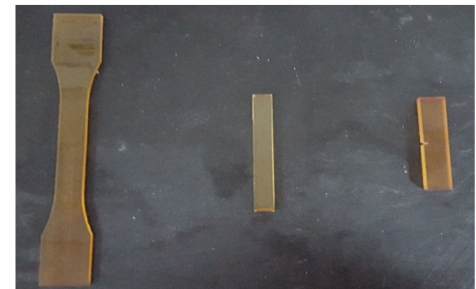
Figure 1. Photo of resin casting